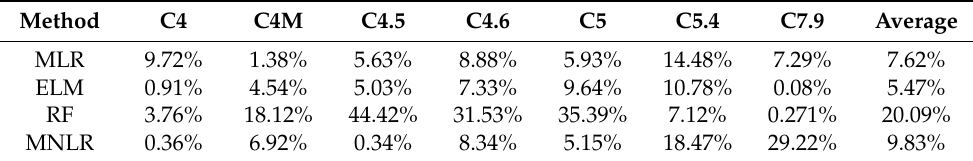
Table 7. Percent error of test samples for each method.